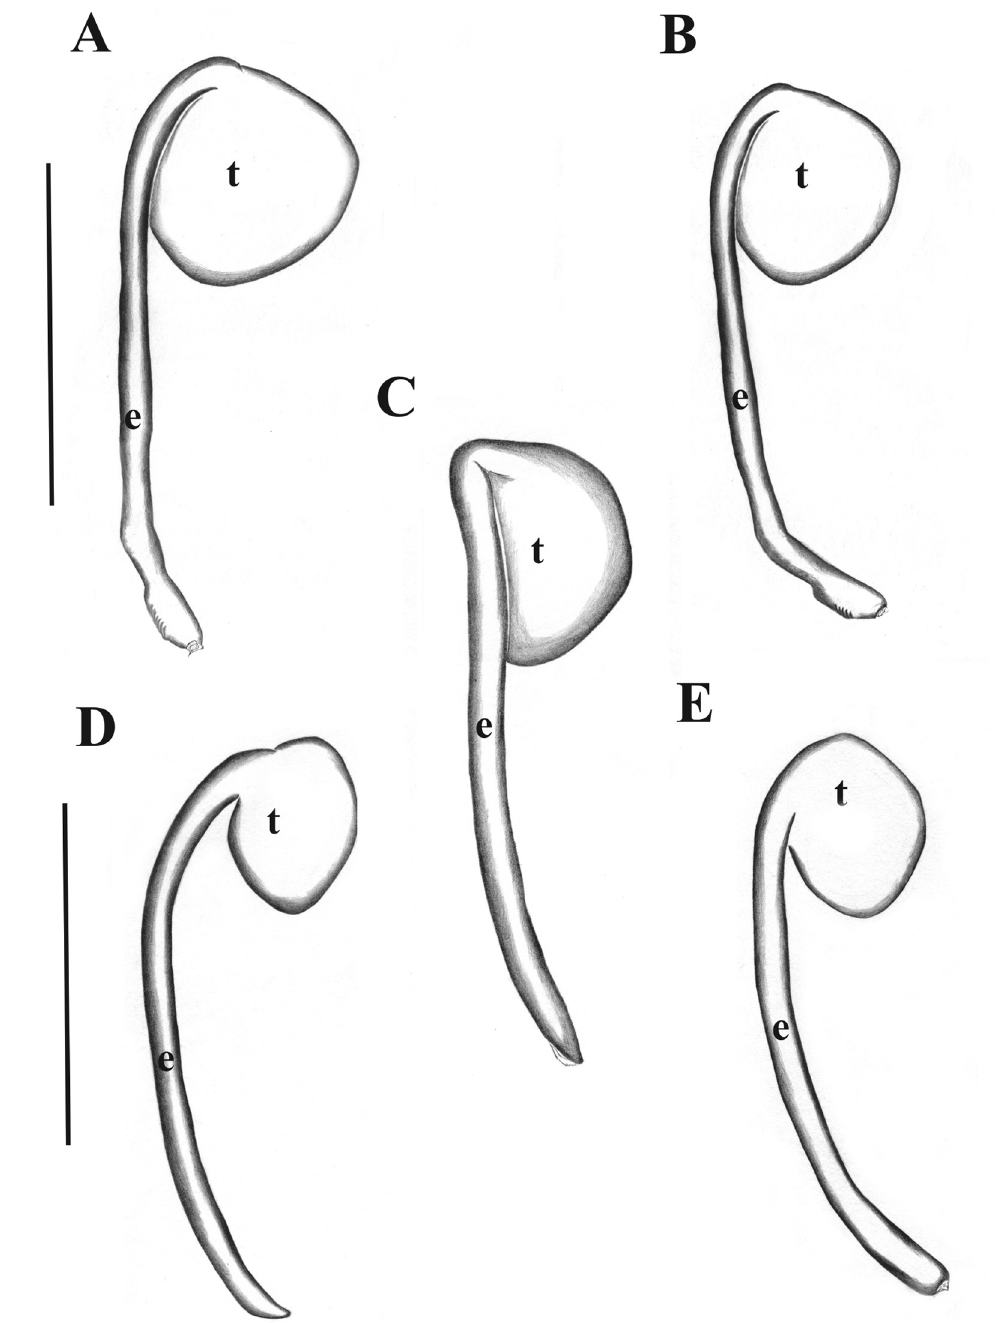
Fig. 7. Drawings of the male copulatory bulbs (retrolateral view) in Colombian species of Medionops Sánchez-Ruiz & Brescovit, 2017. A . M. blades Sánchez-Ruiz & Brescovit, 2017. B . M. carolinae sp. nov. C . M. cauca sp. nov. D . M. luiscarlosi sp. nov. E . M. santarosa sp. nov. Scale bars = 0.5 mm. Abbreviations: e = embolus; t =